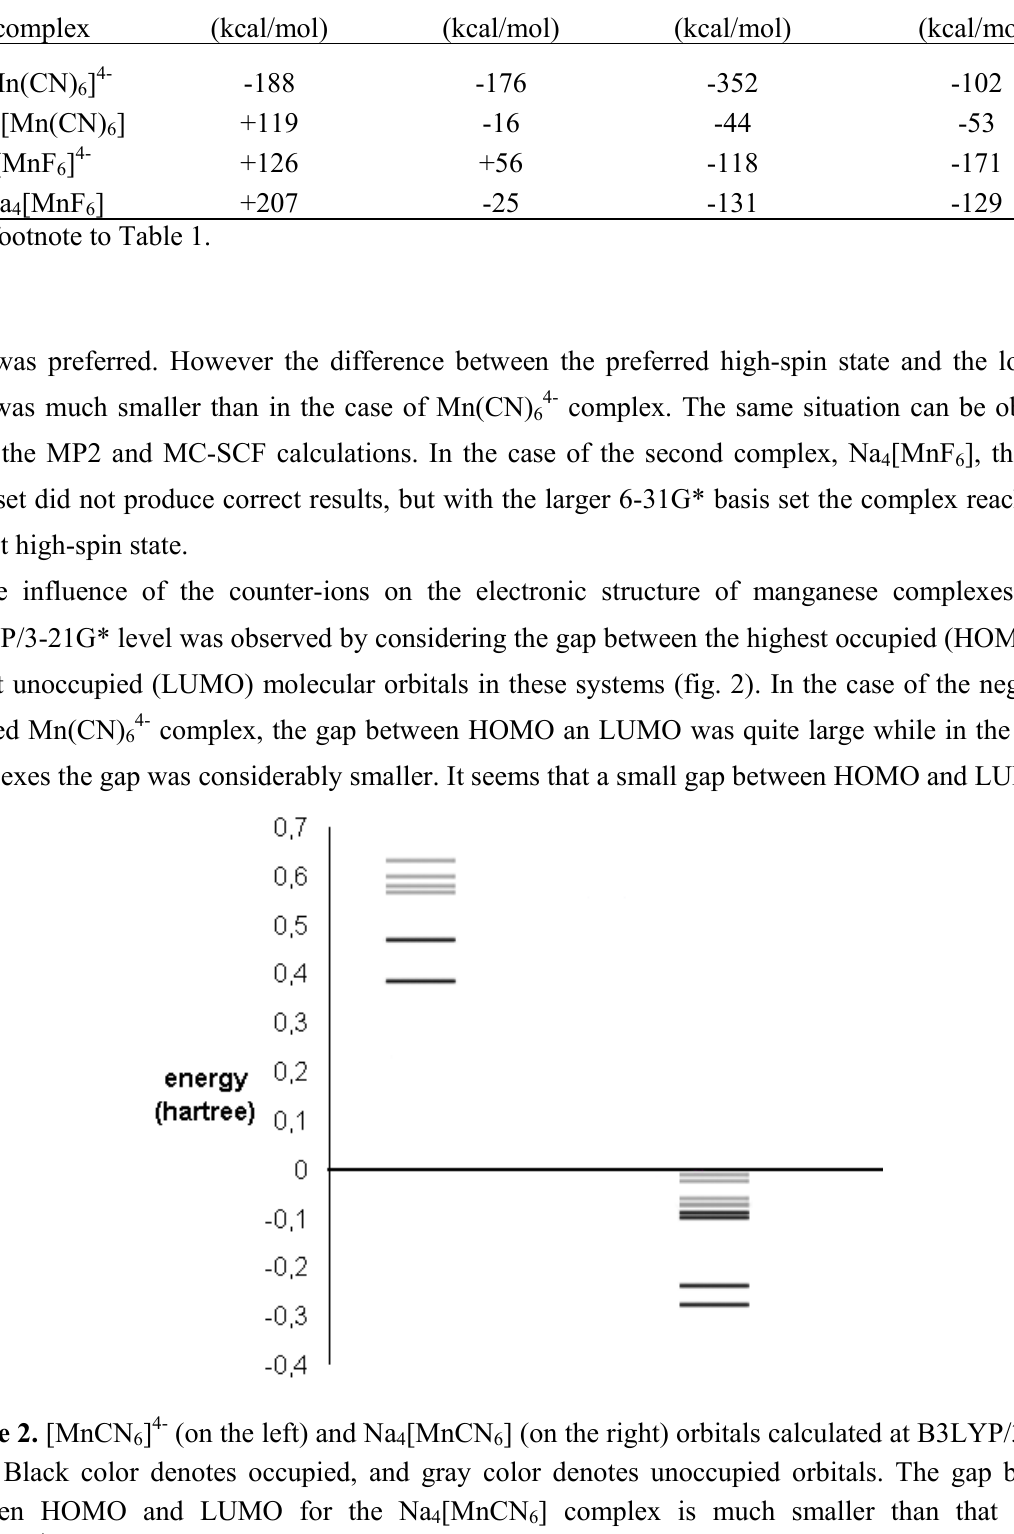
Table 2. Energy difference between high-spin and low-spin states of [MnX complexes using different calculation methods; ∆ E=E(high-spin) – E(low-spin)